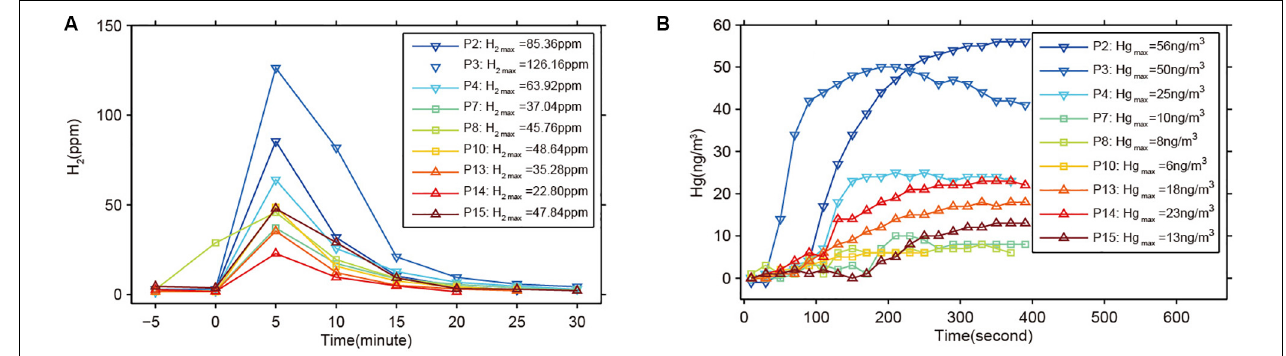
FIGURE 4 | Soil gas H 2 (A) and Hg (B) concentrations at nine sampling sites across the BLT fault zone at Tiemenguan. Different colors represent the variation cures of H 2 (A) and Hg (B) concentration of different measurement sites and the corresponding